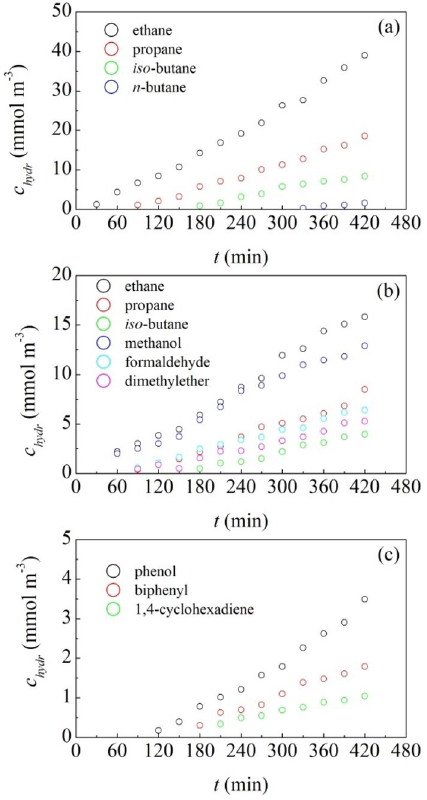
Figure 4. Measured concentration of chemical species, c hydr ( t ) , as a function of time, t . Data refer to experiments in which coarse granite powder is subjected to prolonged mechanical processing in the presence of ( a ) gaseous CH 4 , ( b ) an equimolar CH 4 –O 2 gaseous mixture, and ( c ) an equimolar C 6 H 6 –H 2 O gaseous mixture. The chemical species formed are indicated in the